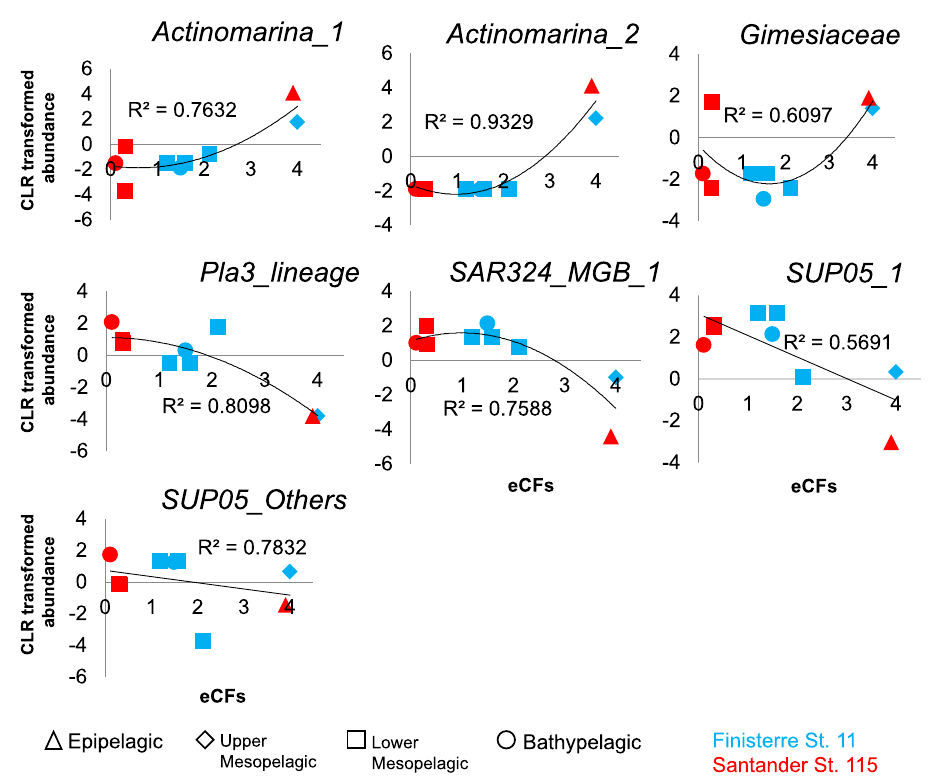
Figure 4. Significant relationships ( P ≤ 0.05) between the CLR transformed abundance of ASVs/phylotypes and the values of eCFs for the corresponding depth range (triangle, epipelagic; diamond, upper mesopelagic; square, lower mesopelagic; circle, bathypelagic), in stations 11 (Finisterre, blue) and 115 (Santander, red). The black line represents the best quadratic model fitted to data, according to the lowest Akaike’s information criteria (see Table S3 in Supplementary Information). R 2 is the coefficient of determination of the fitted